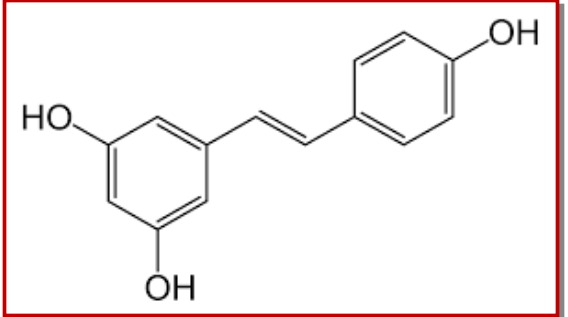
Figure 1: The structure of